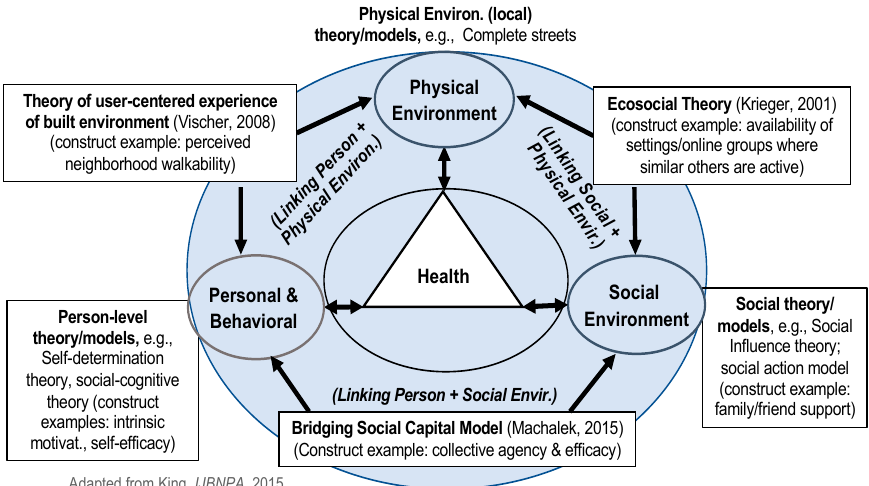
Figure 1. Dynamic theoretical approach to the socio-ecological model of health behavior change.